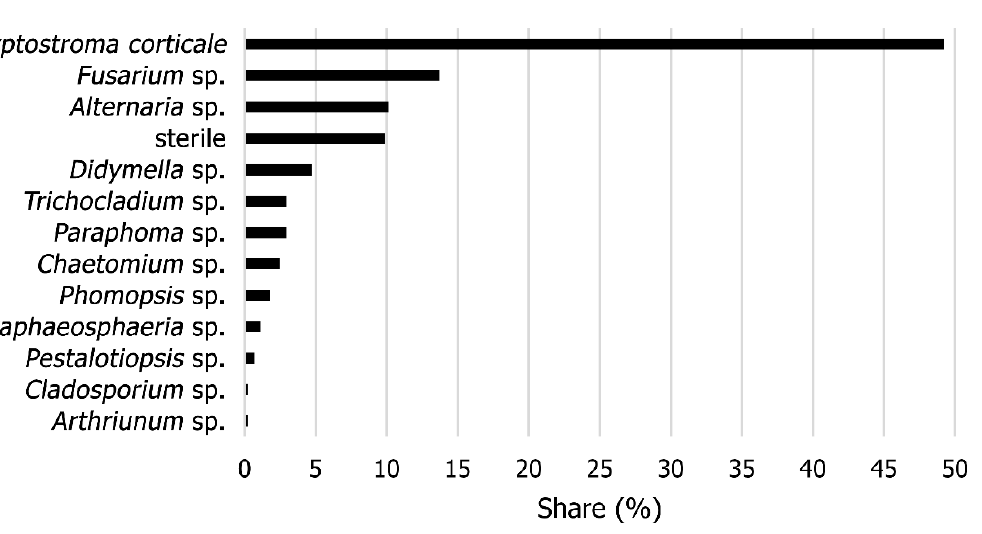
Figure 7. Fungi isolated from two-year-old Acer pseudoplatanus saplings inoculated with Cryptostroma corticale isolate ZLVG 859 after 38 days at 25 °C (% of cultures, n = 445).